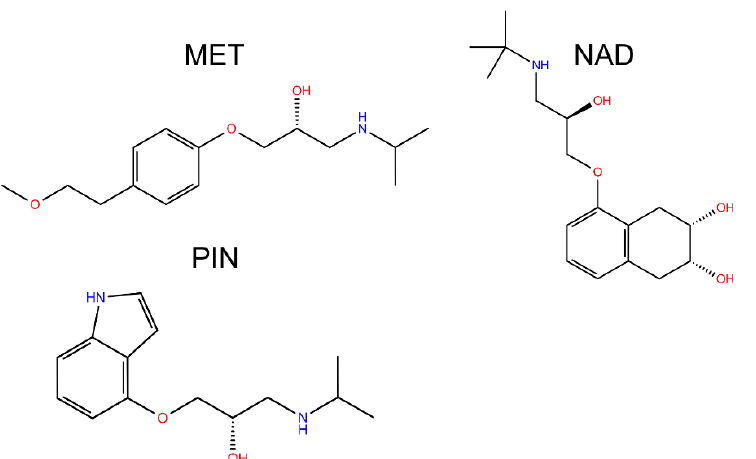
Figure 1. Structural formulas of studied beta blockers.